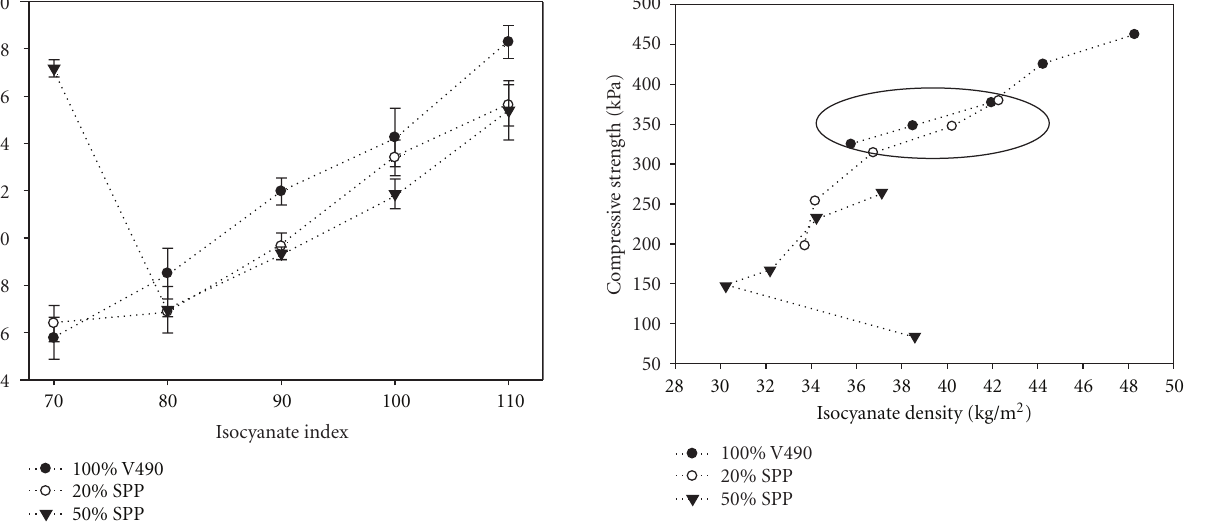
Figure 6: E ff ect of di ff erent isocyanate index on density of rigid PU foams with di ff erent SPP percentages.